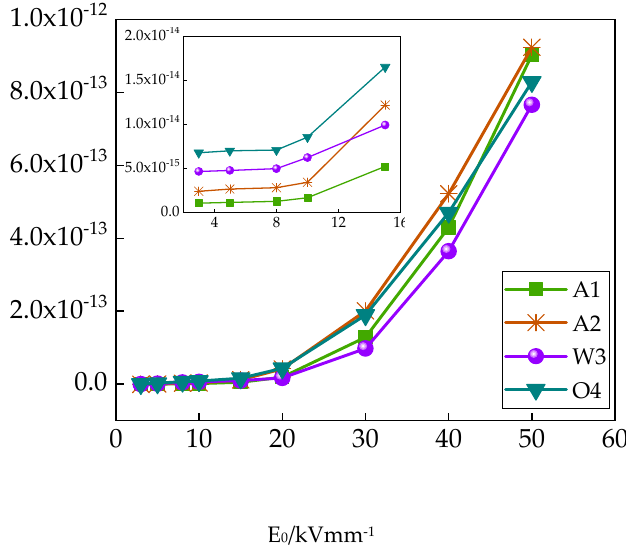
Figure 3. Curves of different LDPE samples’ conductivity changing with field strength.